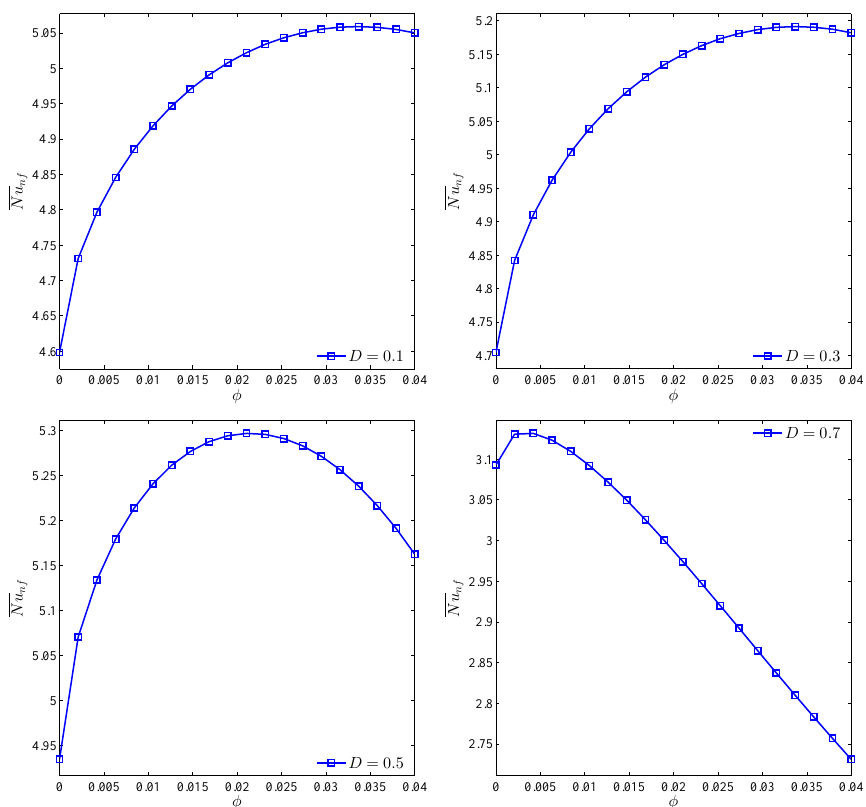
Figure 18. Variation of average Nusselt number with φ for different D at Ra = 10 5 and k w = 0.76.